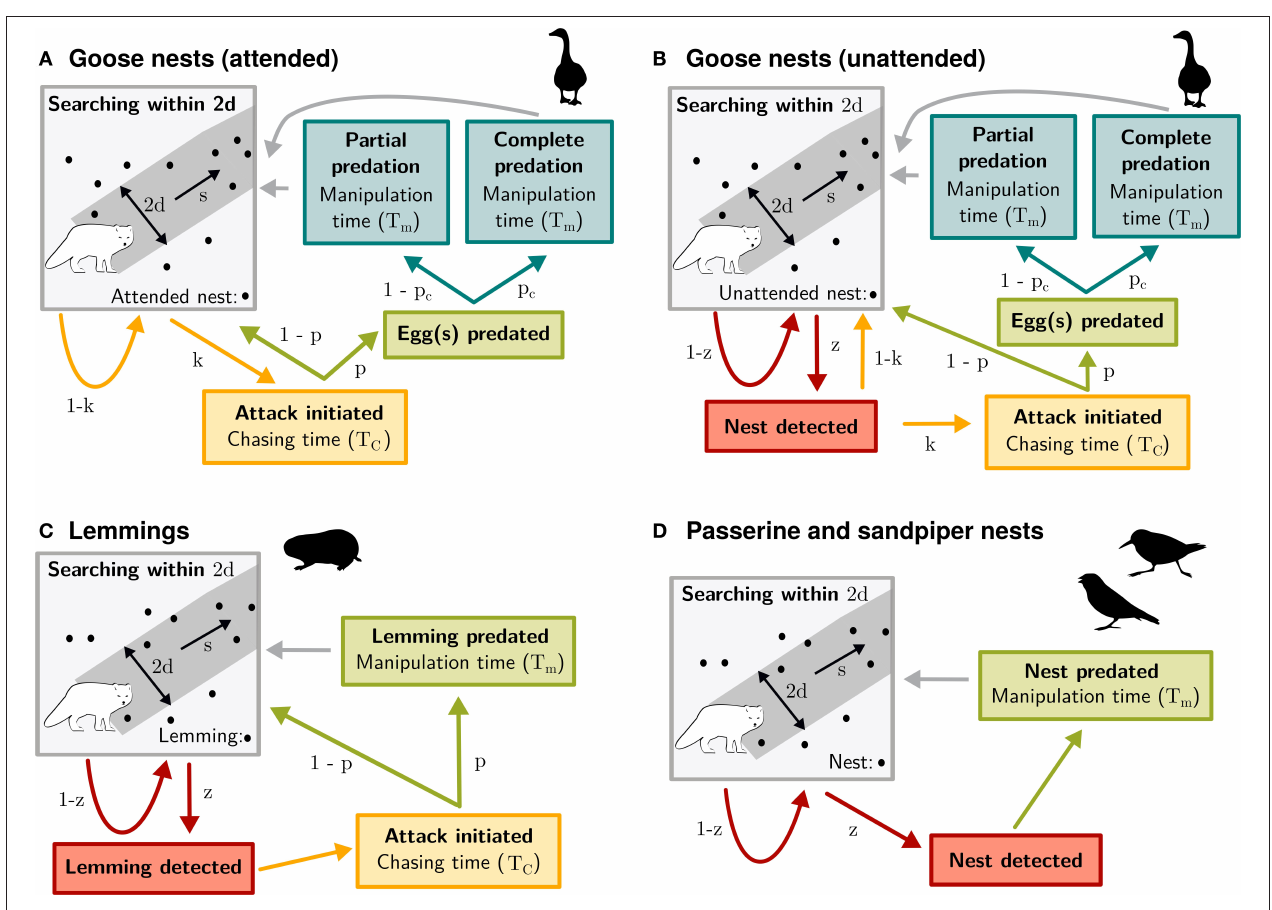
FIGURE 1 | Conceptual mechanistic model of functional response of arctic fox to each prey species: attended (A) or unattended (B) goose nests, lemmings (C) , and passerine and sandpiper nests (D) . Predation was divided into four main components: search, detect, attack, and handle (which includes eating and hoarding). Arrows illustrate the probability that the predator reaches the next component. When there is no parameter indicated beside the arrow, the probability is 1. Parameters are as follows: d is the reaction distance, s the predator speed, z the detection probability, k the attack probability, p the success probability, P c the probability of complete nest predation, T C the time spent chasing, and T m the time spent manipulating the